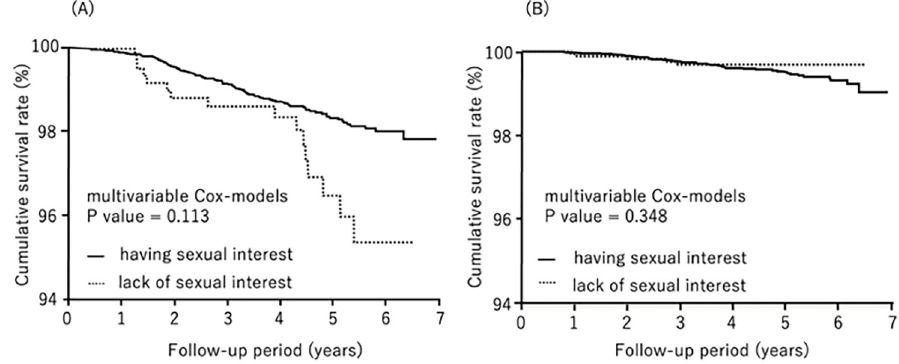
Fig 2. Kaplan-Meier analysis for cancer survival by sexual interest. (A) males, (B) females.